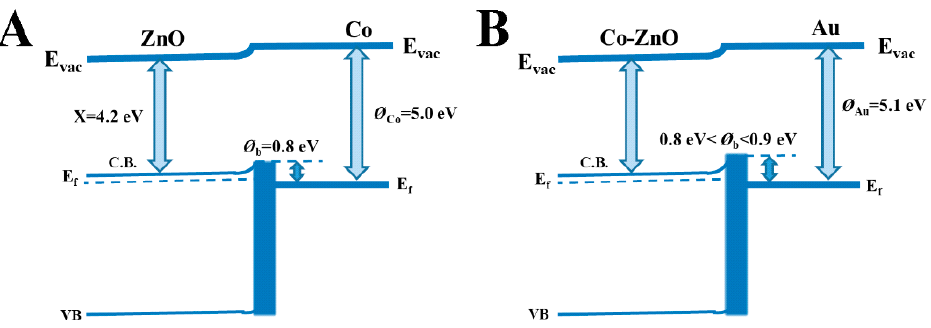
Figure 2. Proposed band structures of the Co 400 -ZnO ( A ) and Co 400 -ZnO/Au ( B ).